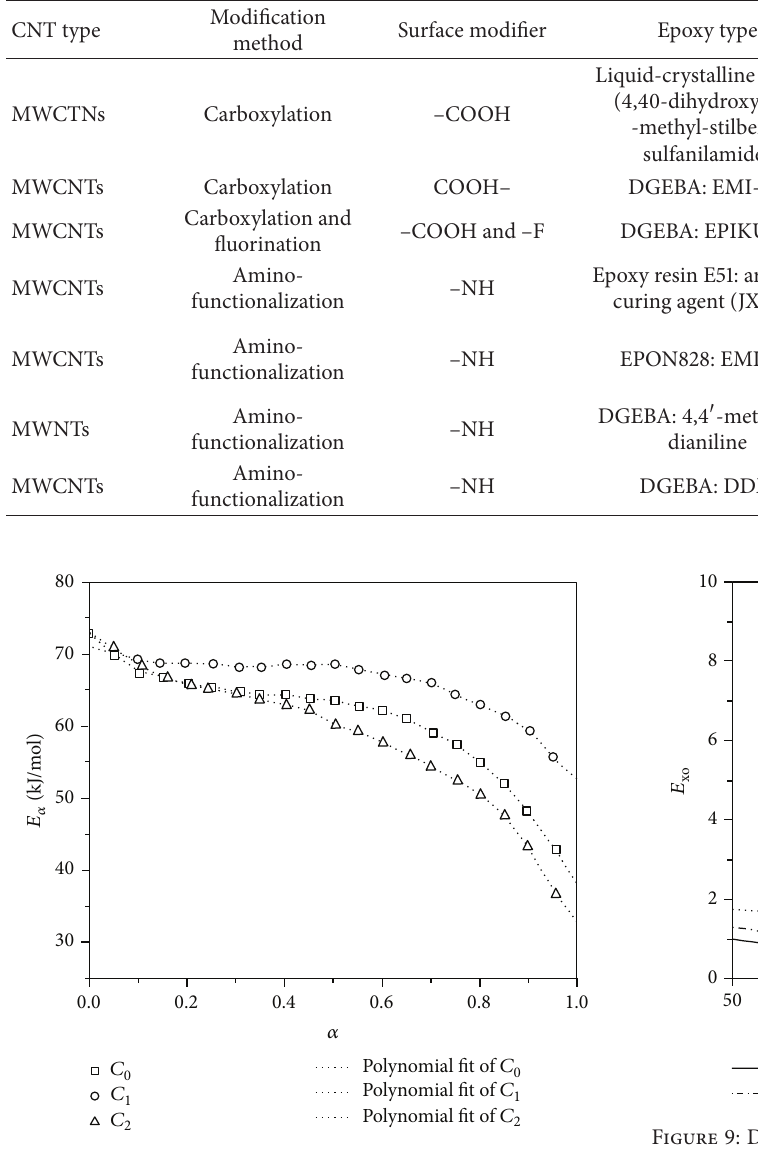
Figure 8: Plots of activation energy of neat epoxy ( 𝐶 0 ), 0.5wt% as-received MWCNTs/epoxy nanocomposites ( 𝐶 1 ), and 0.5wt% amine-modified MWCNTs/epoxy nanocomposites ( 𝐶 2 ) against degree of cure obtained by isoconversional kinetic model. After [10].